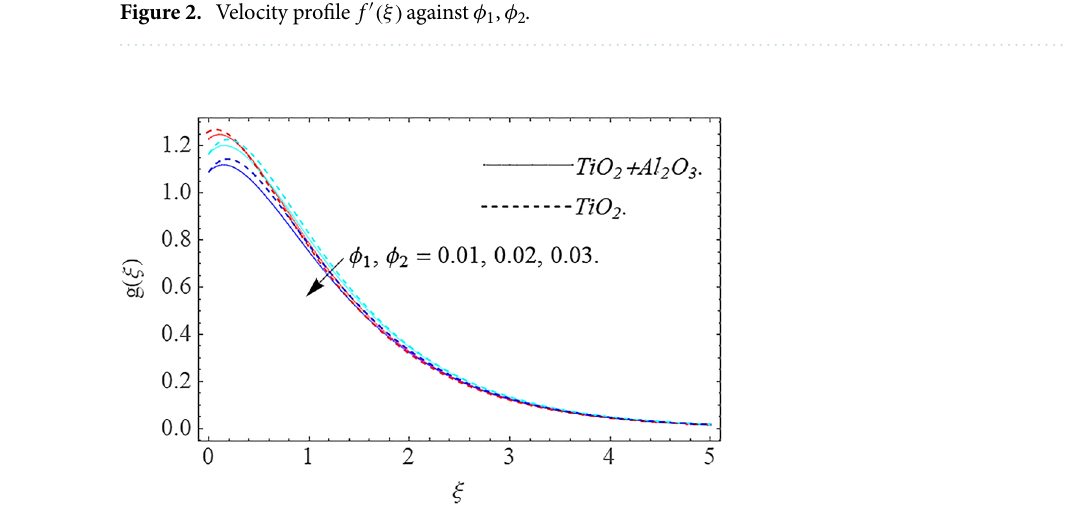
Figure 2. Velocity profile f ′ (ξ) against φ 1 , φ 2 .